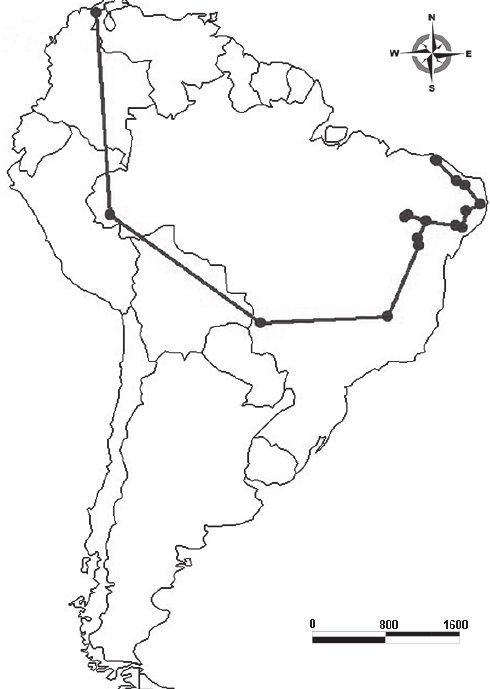
Fig. 16 - Individual track of Palaeolama major .